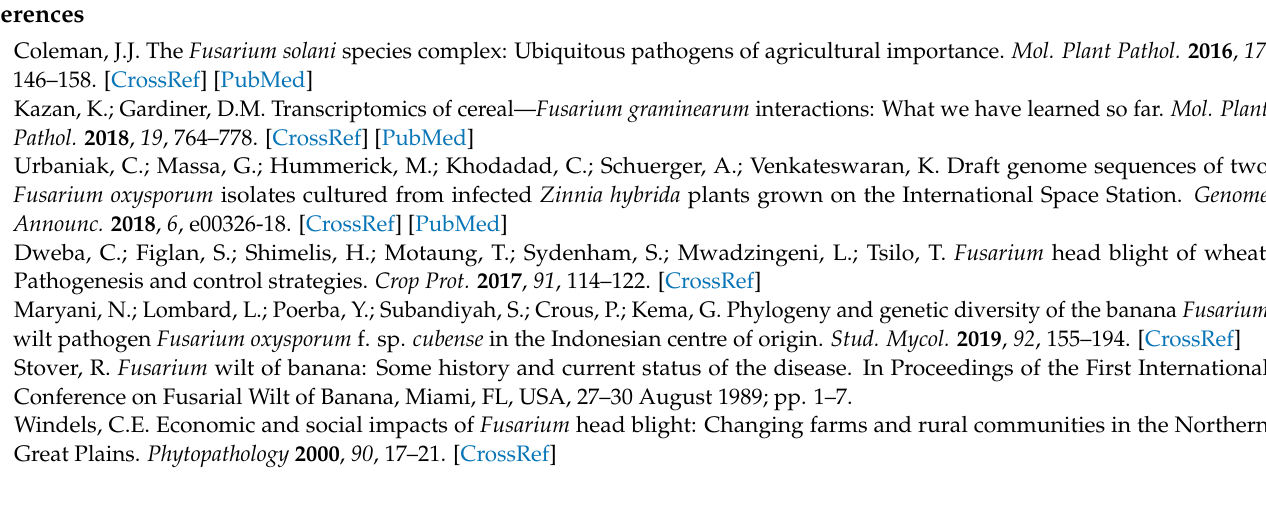
genes. Table S2: Source, species and MLST of 37 Fusarium isolates selected for the phylogenetic analysis of TEF1- α and RPB2 sequences presented in Figure